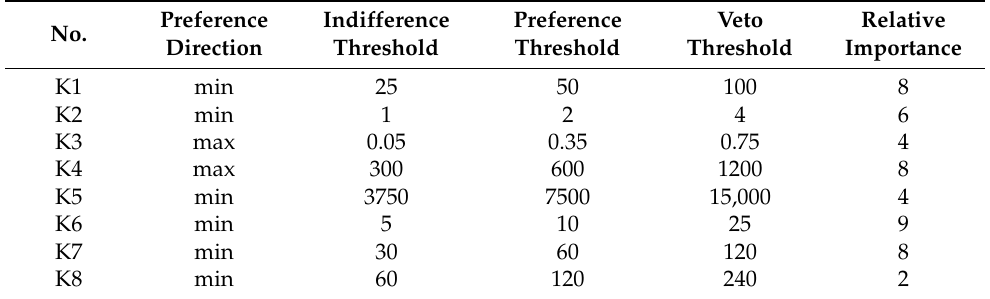
Table 7. Decision-maker’s preference model—Expert 4—local government official expert on environment.